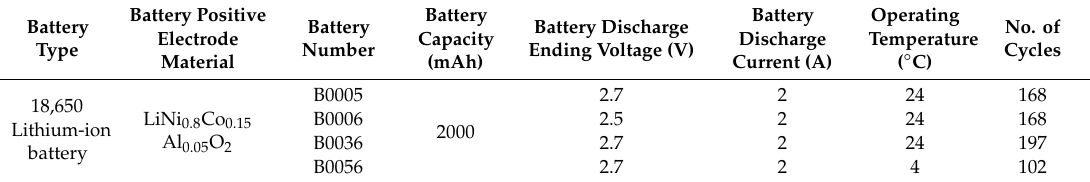
Table 1. Specifications and operating conditions of batteries [35] .